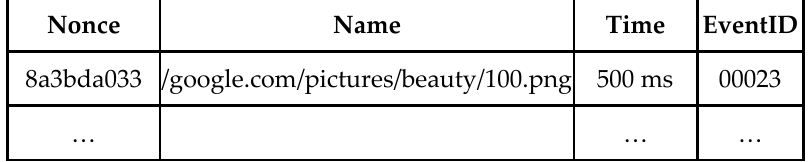
Figure 4. Control fields of Interest packets. For the Data packet, too, we add to the original NDN fields (name, signature, and content) the priority of the content, in the MetaInfo field, and specify who should receive, process, and forward the Data packet, in the Next_position field. Figure 5. Control fields of Data packets.